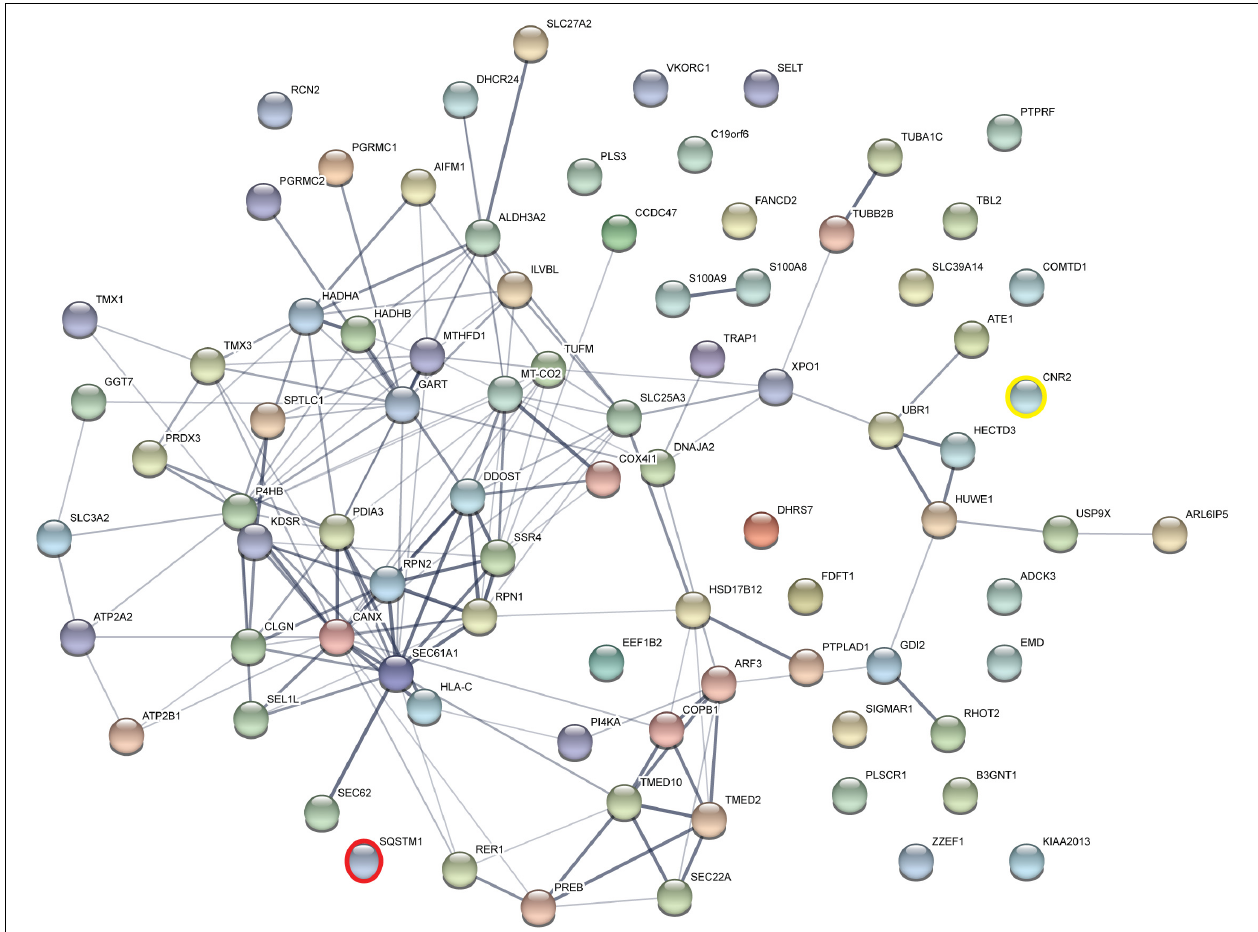
FIGURE 2 | Functional Annotations were used to visualize protein–protein interaction network of 83 identified CB2 interactors by STRING. Illustrated interaction network was determined by text mining, experiments or databases with a minimum required interaction score of 0.400. In this view, the nodes represent proteins and the color saturation of the edges represents the confidence score of data support. CNR2 represents CB2 and SQSTM1 represents p62.